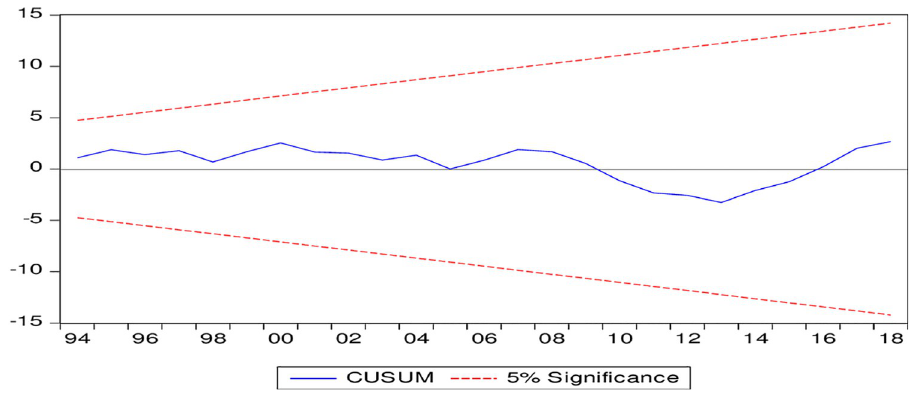
Fig 3. Plot of cumulative sum of recursive residual.